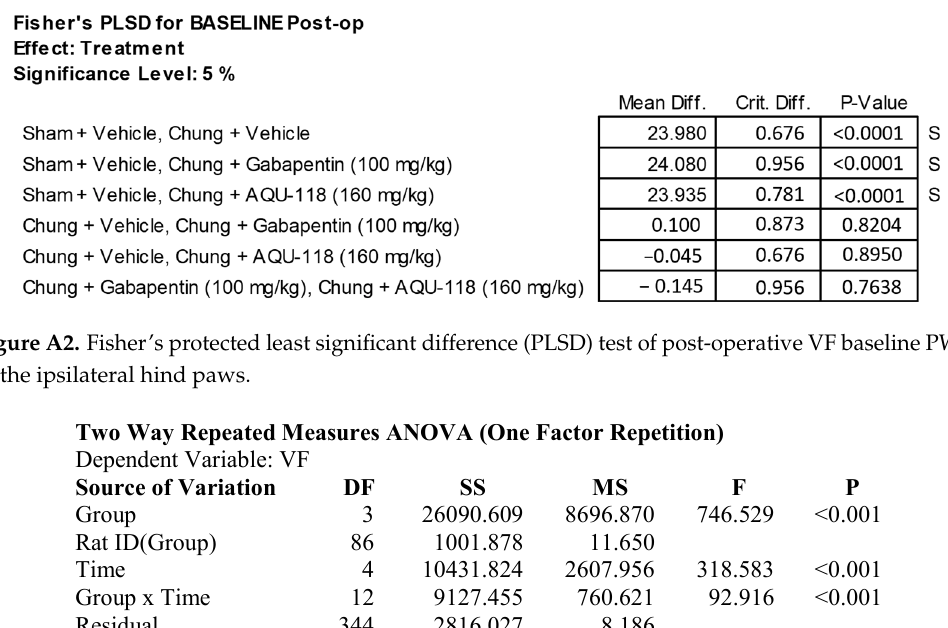
Figure A1. Statistical analysis of post-operative von-Frey (VF) baseline paw withdrawal threshold (PWT) of the ipsilateral hind paws. All Chung surgical groups showed a significant decrease in the PWT compared to the sham surgical group. No significant difference in post-operative baseline PWT was detected between the individual Chung surgical groups.